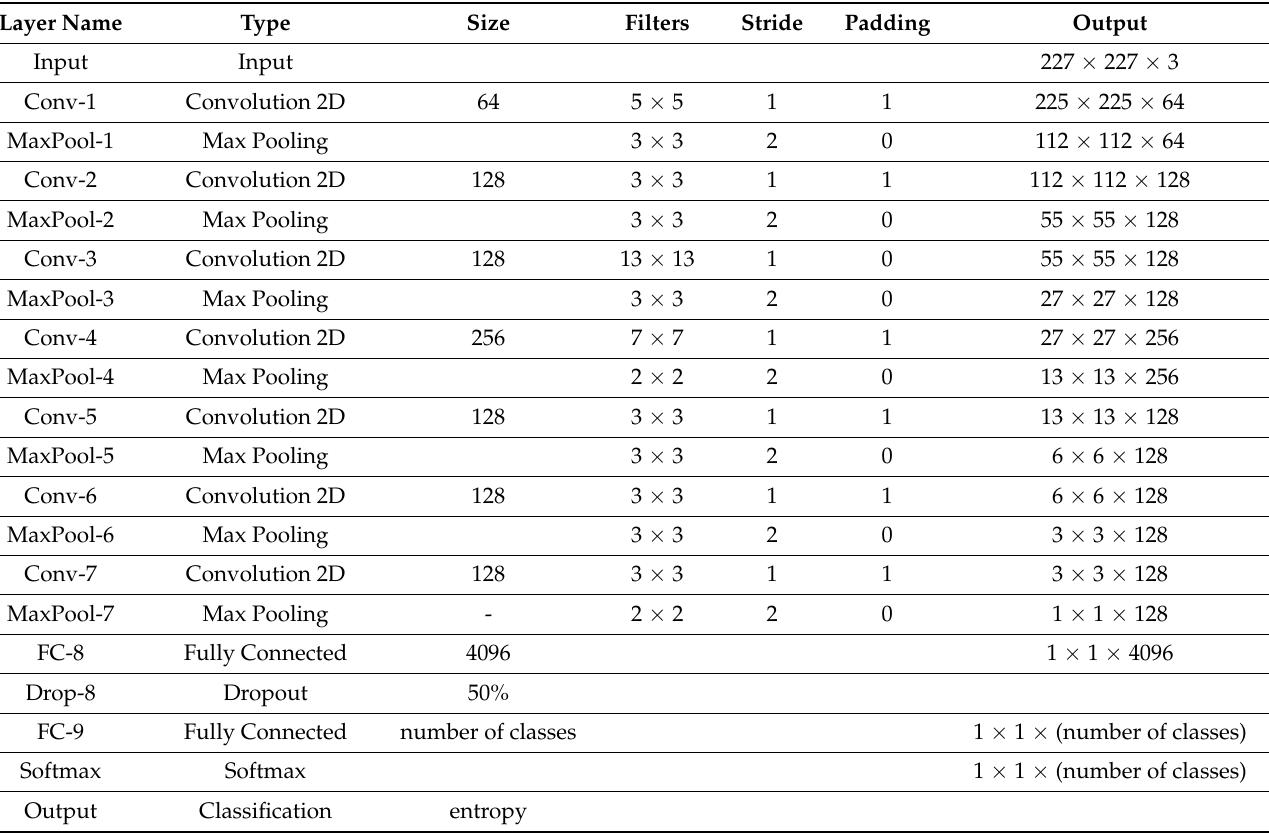
Table 1. Parameters details of